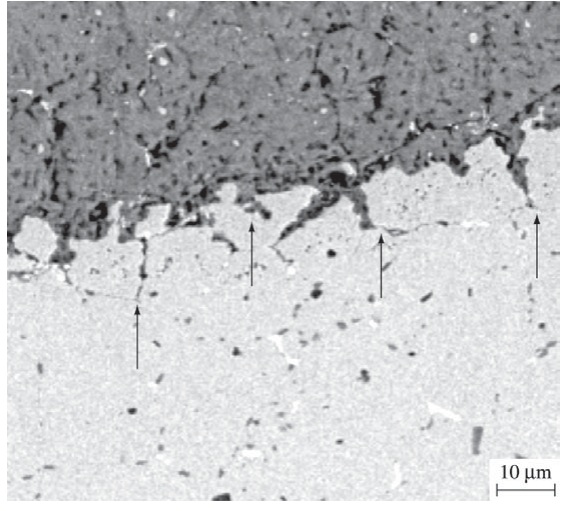
Figure 4. SEM micrograph of the corroded layer/substrate inter- face, showing the internal oxidation and sulfidation of the G11 steel sample subjected to the real condition at 650